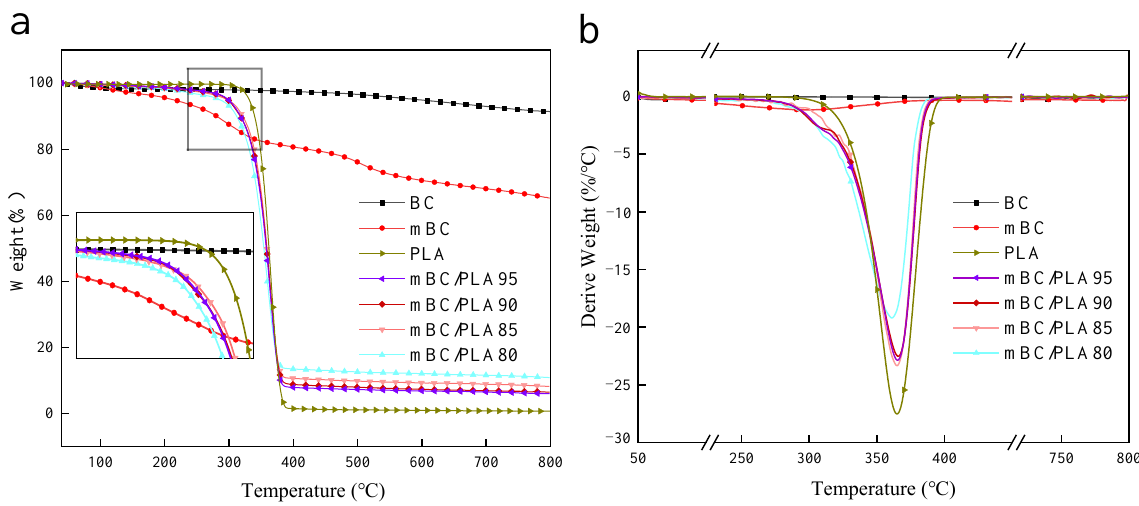
Figure 6. Thermogravimetry ( a ) and derivative thermogravimetric ( b ) curves for virgin BC, mBC and mBC/PLA composites analyzed under nitrogen atmosphere.